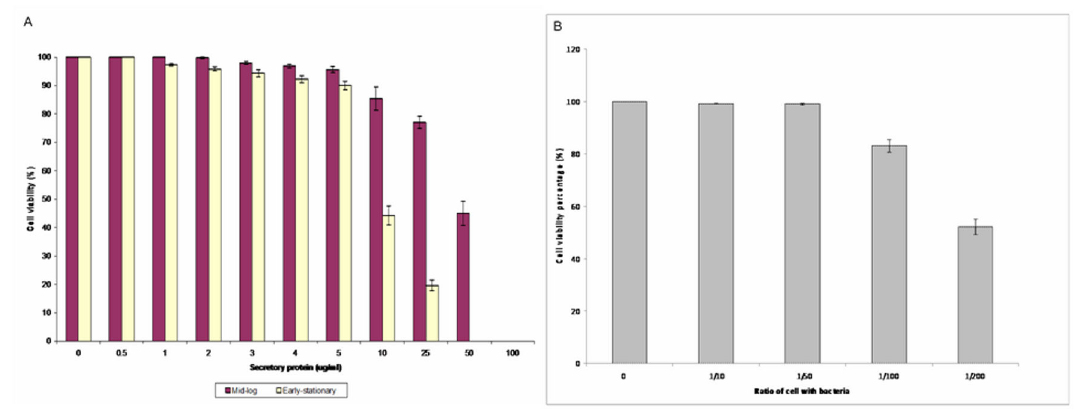
Figure 3. Percentage of A549 lung epithelial cells exposed to (panel A) secretory proteins (mid-logarithmic and early- stationary phases) ranging from 0 µg/ml-100 µg/ml and (panel B) live B. cepacia (mid- logarithmic phase) for three hours from 1:10 -1:200 using Trypan blue solution. The error bars indicate the standard deviation of triplicate values. The red box indicates the concentration choosen for microarray analysis.